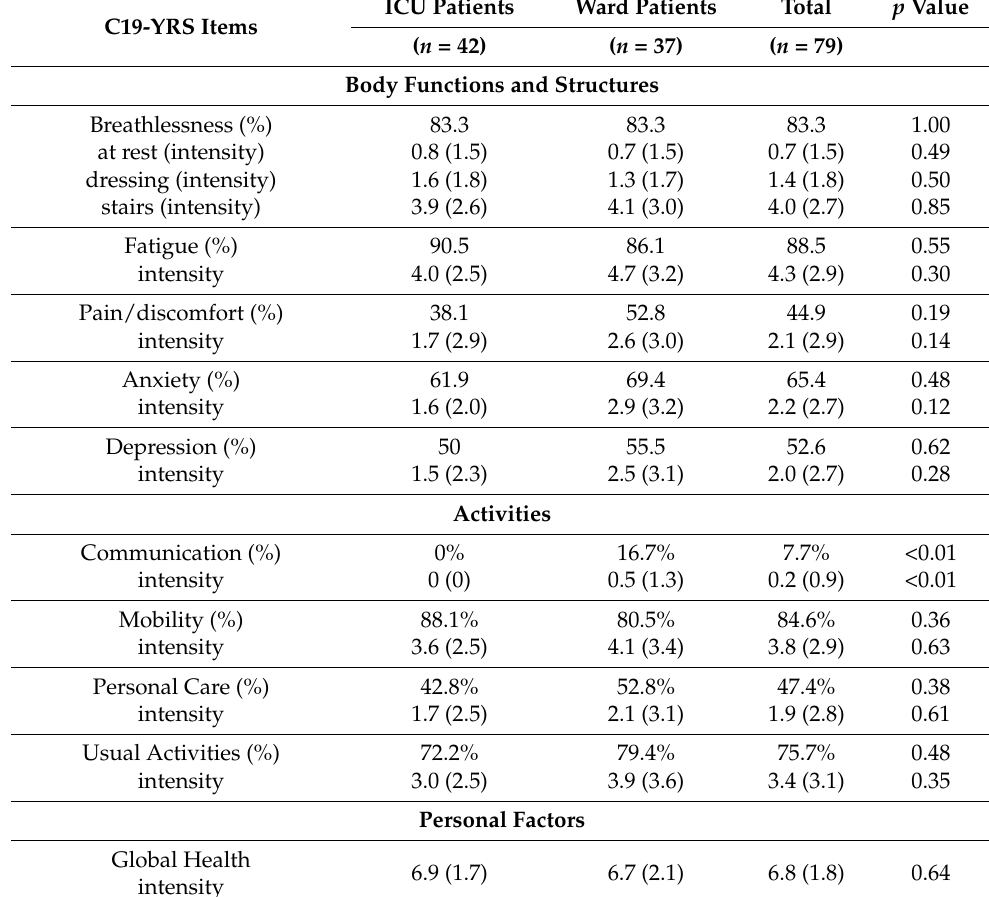
Table 3. COVID-19 symptoms after 12 weeks. Abbreviations: ICU = Intensive Care